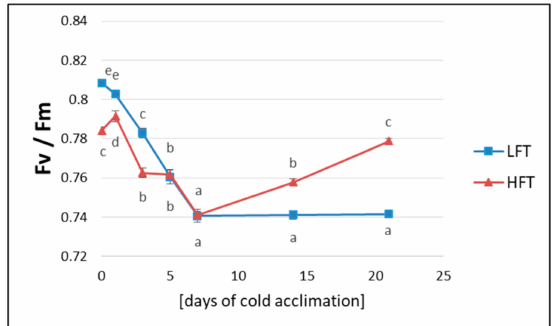
Figure 2. Changes in maximum quantum yield of primary PSII photochemistry ( Fv / Fm ) (yield ratio was calculated for t = 0) in the high (HFT) and the low freezing tolerant (LFT) Lolium multiflorum / Festuca arundinacea introgression forms, at seven time-points: before cold acclimation (CA) and on the 1st, 3rd, 5th, 7th, 14th, and 21st day of CA. Error bars represent the standard errors of ten replicates. Homogeneity groups are denoted by the same letters, according to Fisher’s LSD test ( p =